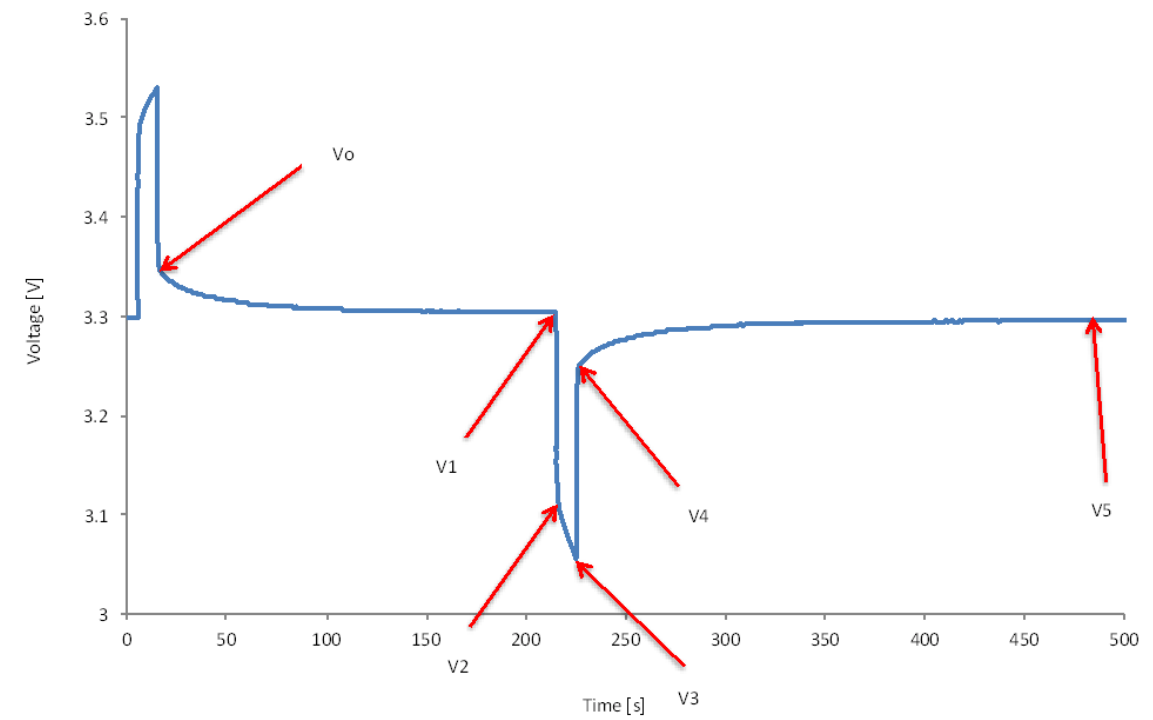
Figure 26. Voltage duration during HPPC